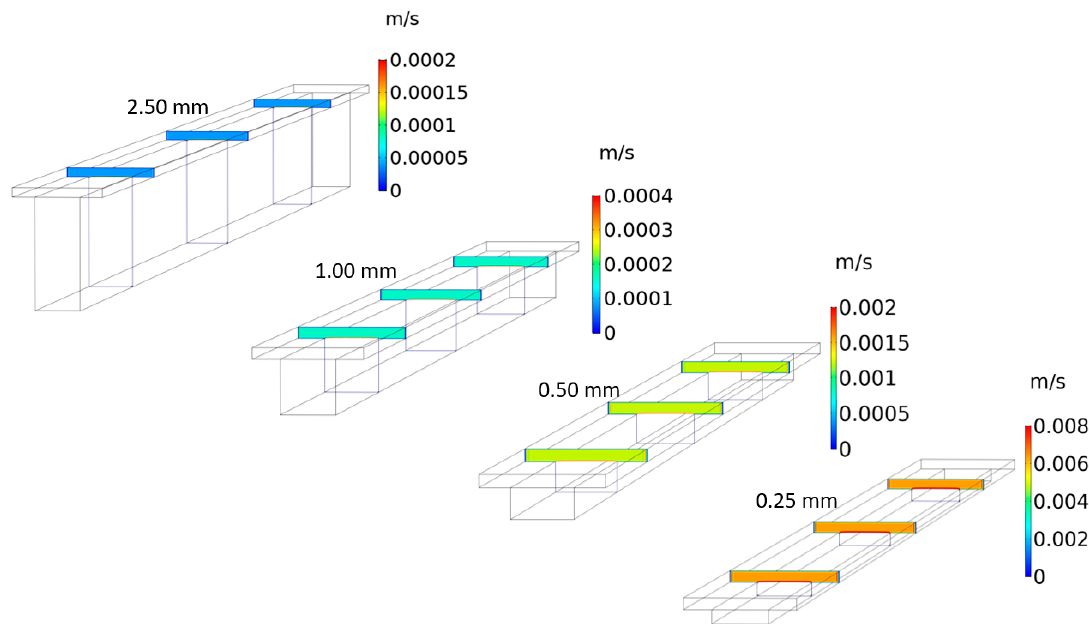
Figure 6. Predicted electrolyte velocity distribution at a cut plane through the electrode domain for all channel depths at a 30 mL min − 1 flow rate.